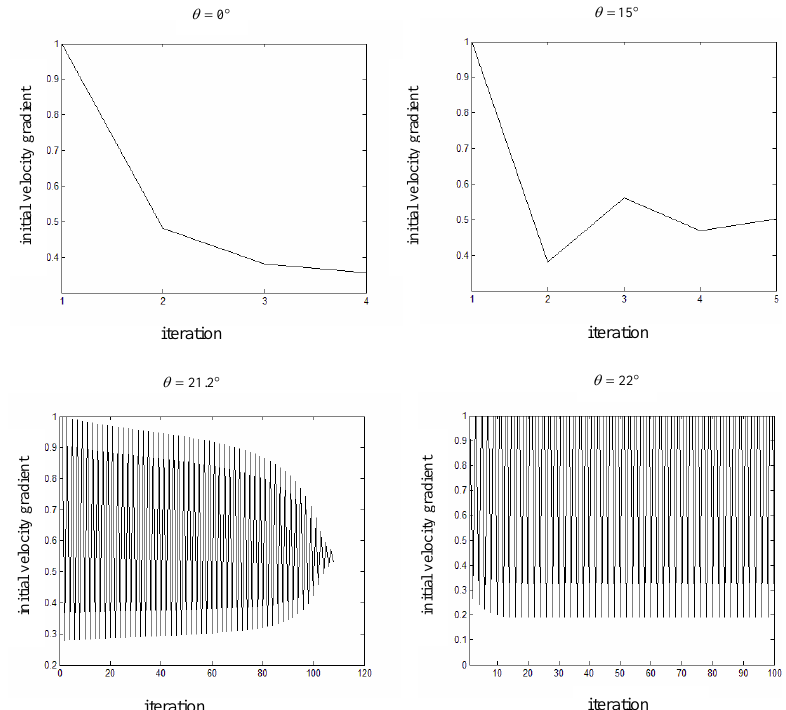
Fig. 5. It is observed that as the wedge angle increases, the number of iterations required to estimate the velocity gradient at the surface of the wedge increases and when the wedge angle is 22 ◦ , the solution does not converge.